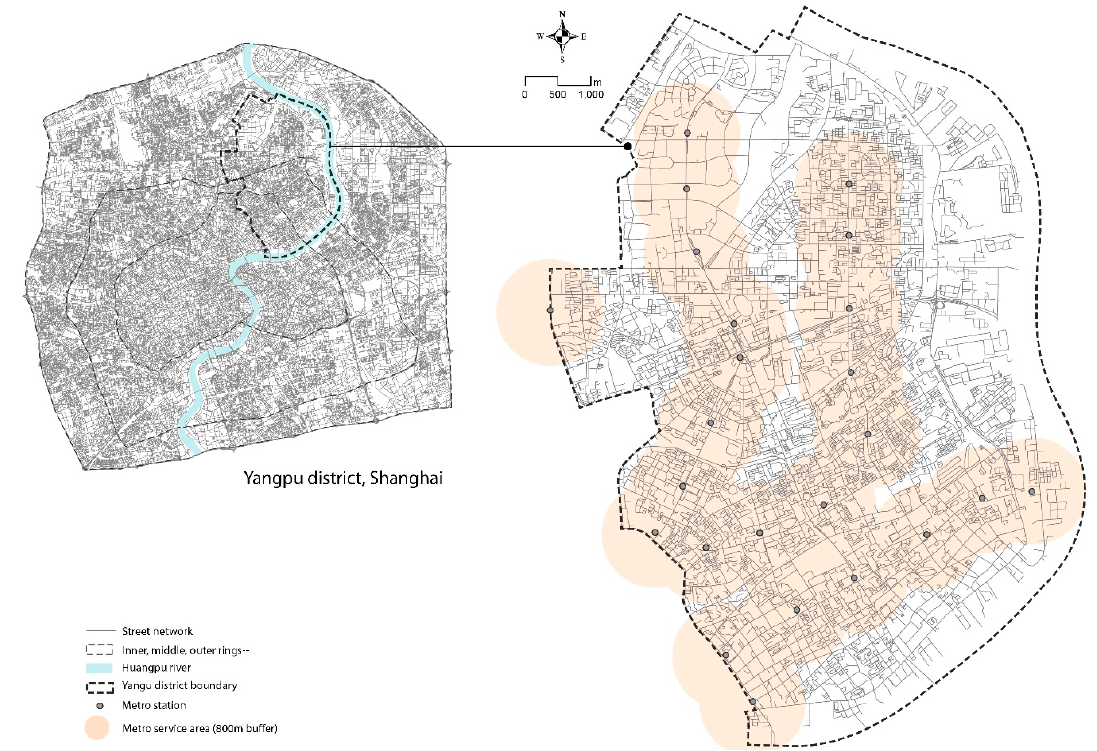
Figure 2. The study area and metro service area